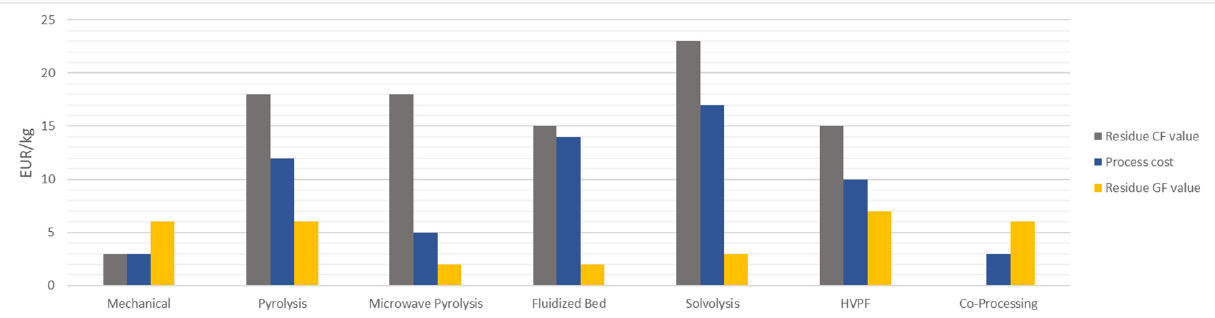
Figure 5. Estimated process-related costs and residue material value. (Based on Figure 4, Tables 1 and 2 and [30,56]).